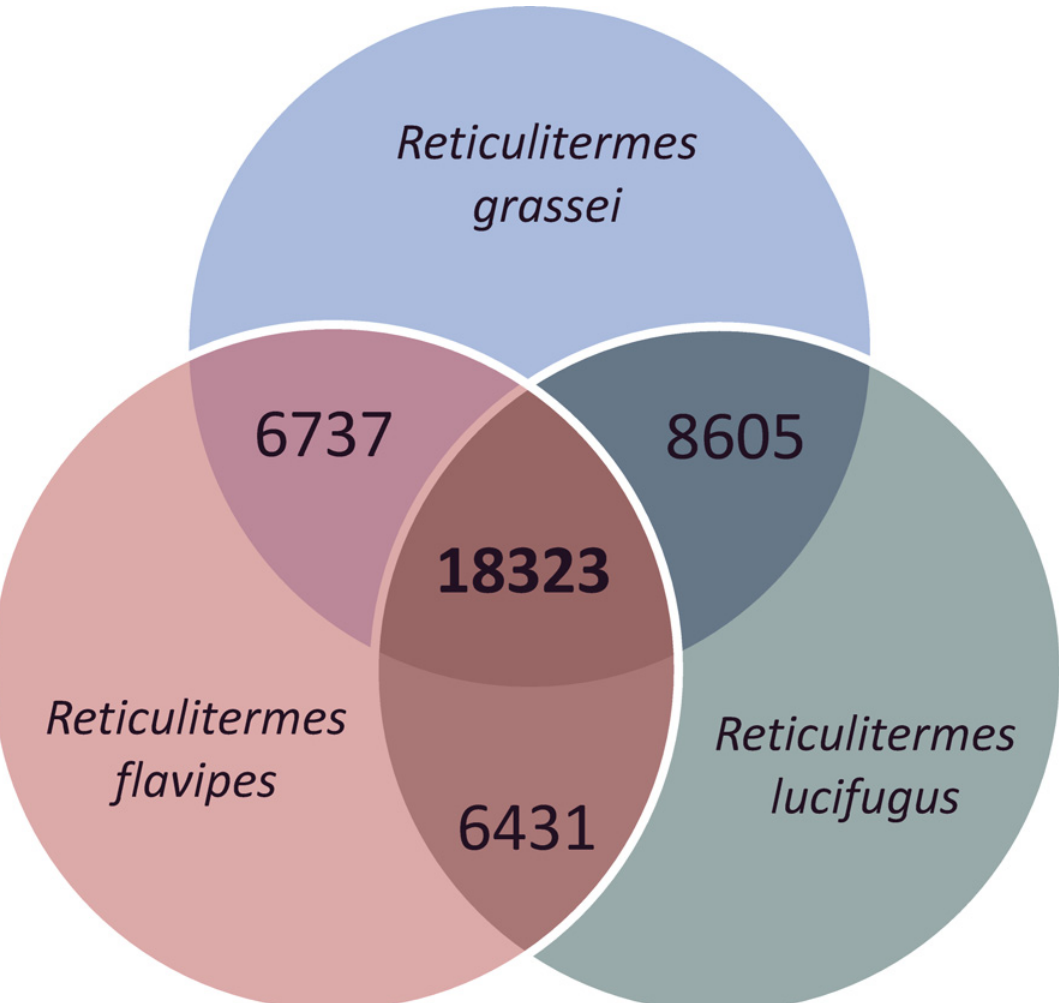
Fig 1. Orthology relationships between R . grassei , R . flavipes and R . lucifugus contigs. The number of orthologous gene clusters is indicated inside Venn diagram.